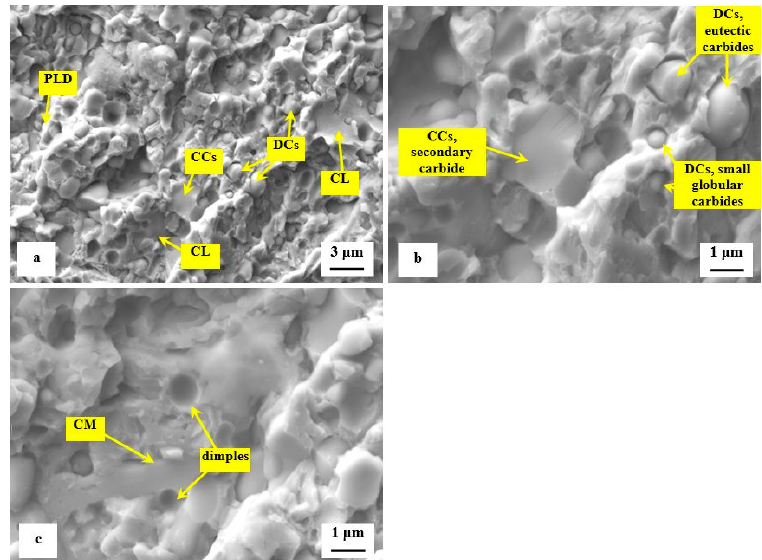
Figure 12. SEM images showing details of fracture propagation in sub-zero treated and no-tempered fracture toughness specimen, ( a ) detailed image showing the crack propagation in the matrix and the three main carbides including their role in fracture propagation, (CCs—cleaved carbides, DCs—decohesive carbides, PLD—plastic deformation in the matrix, CL—cleaved matrix), ( b ) high-magnification image showing cleaved M 7 C 3 (CCs, secondary carbide), and decohesive particles that belong to eutectic carbides (DCs, eutectic carbides) and small globular carbides, and ( c ) high-magnification image showing cleaved matrix region (CM) and small dimples resulting from the extraction of small globular carbides.